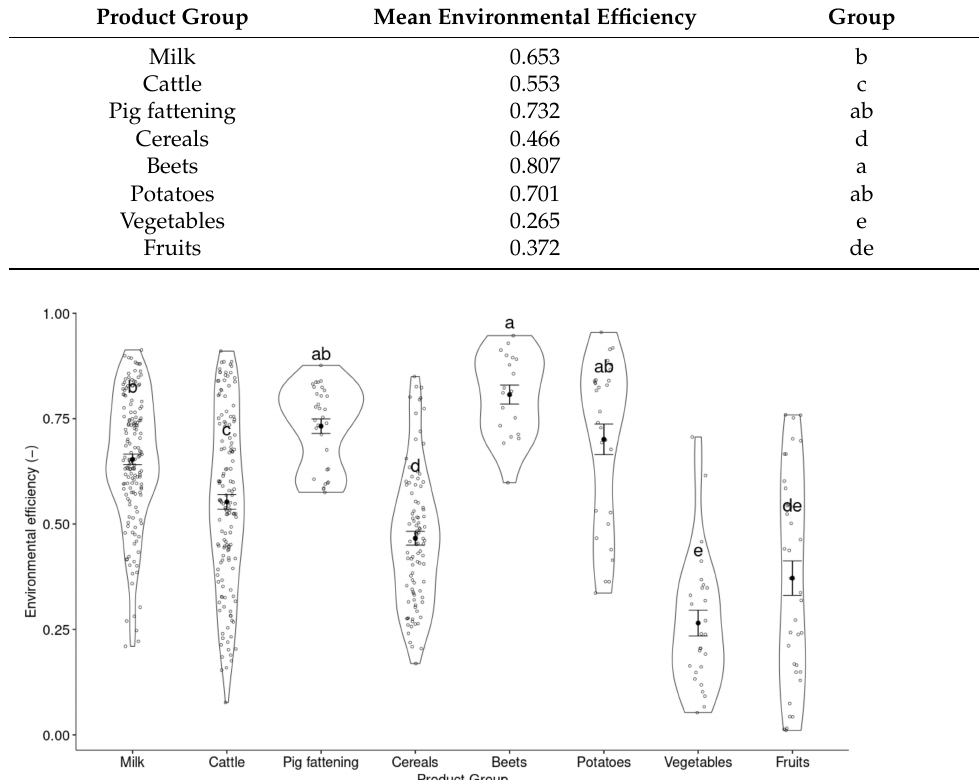
Figure A9. Post-hoc test variance analysis: Product groups vs. environmental efficiency. Shown are the 95% confidence levels for between product group differences in mean environmental efficiency scores. The abbreviations indicate contrasting product groups: Ve = Vegetables, Pi = Pig Fattening, Mi = Milk, Fr = Fruits, Ce = Cereals, Be = Beets, Po = Potatoes, Ca = Cattle. Table A6. Summary one-way ANOVA environmental efficiency. The group column indicates significant differences. (i.e., the same letter indicates non–significant differences in variance, see also Appendix A, Figure A10).